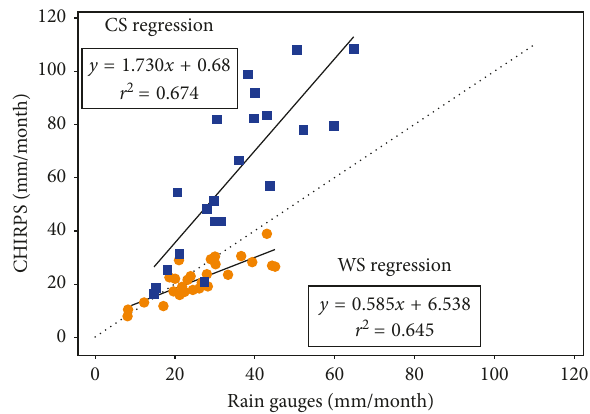
Figure 5: Scatter plot comparing the 49 rain gauge data with the corresponding grids of CHIRPS estimations in mm/month over the 1987–2016 period. Circles indicate the values of the stations located over the WS region, and squares indicate the values of the stations located over the CS region. The black lines indicate the linear regression fits. The dashed line represents a 1 :1 relation.